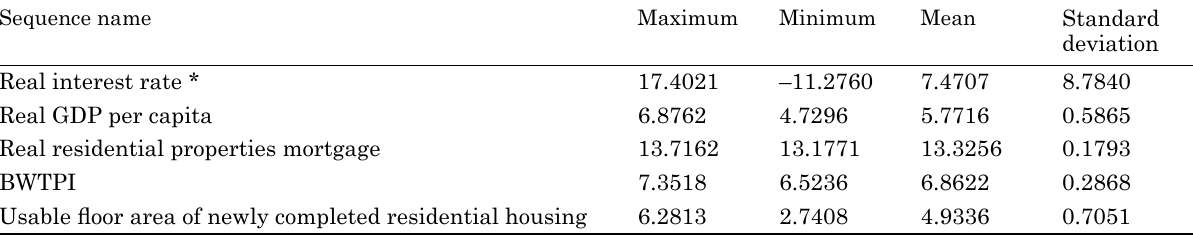
table 3. Basic statistics for the logarithm of time-series sequences in this